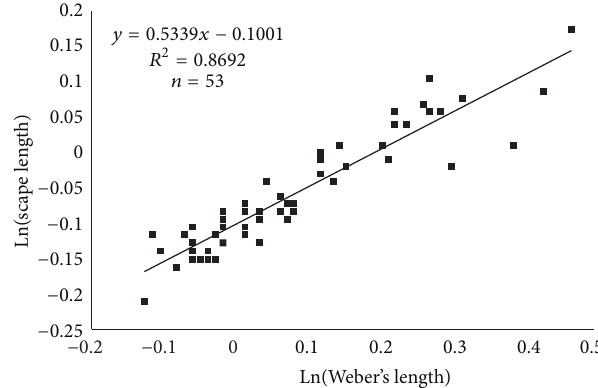
Figure 5: Distribution map of Crematogaster coriaria Mayr, 1872, specimens examined during this study.